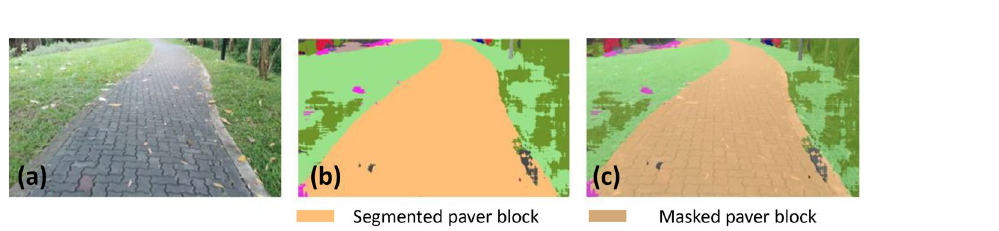
Figure 21. Online results: paver block.